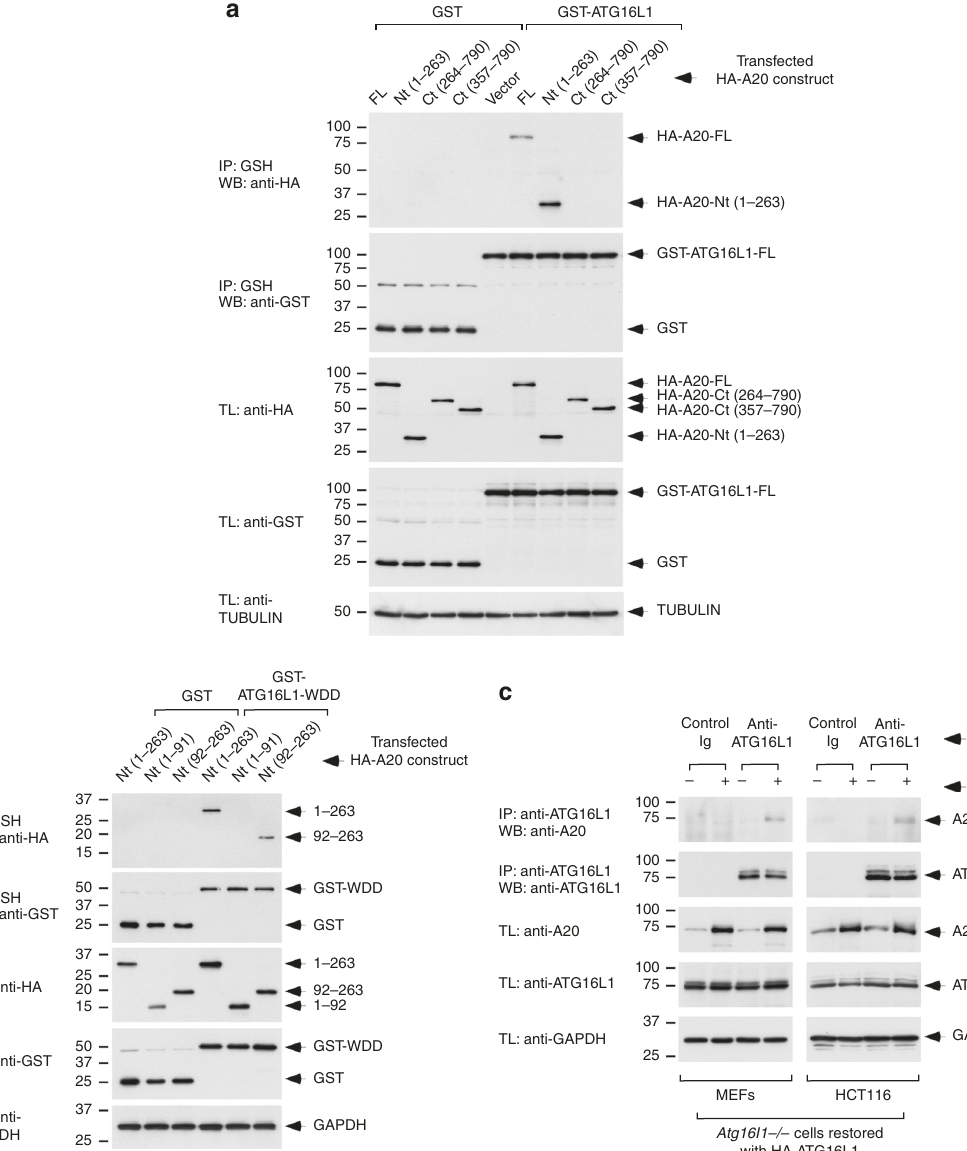
Fig. 3 ATG16L1 recognizes the N-terminal region of A20 (92 – 263) through the WDD. a A stretch of A20 including amino acids 1 – 263 suf fi ces to co- precipitate with GST-ATG16L1. b A minimal region between amino acids 92 – 263 of A20 suf fi ces to interact with the WDD of ATG16L1. Co- immunoprecipitation assays were done as in Fig. 2. c Endogenous A20 coprecipitates with ATG16L1 upon TNF treatment of Atg16L1 − / − MEFs and HCT116 cells restored with HA-ATG16L1. The indicated cells were treated with 30 ng/ml of TNF for 2 h, and processed for anti-ATG16L1 immunoprecipitation and western-blotting with the shown